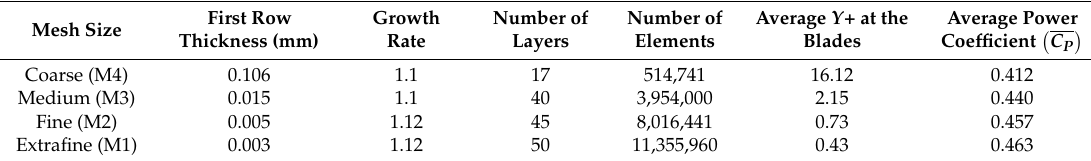
Table 1. Parameters for different mesh sizes close to the blades.